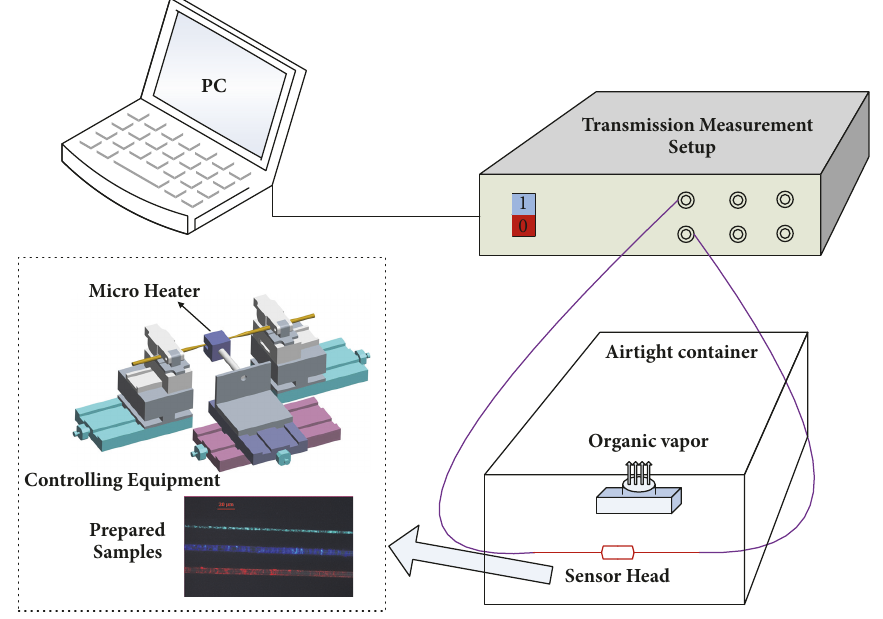
Figure 2: Experimental setup of coated OMF sensor.